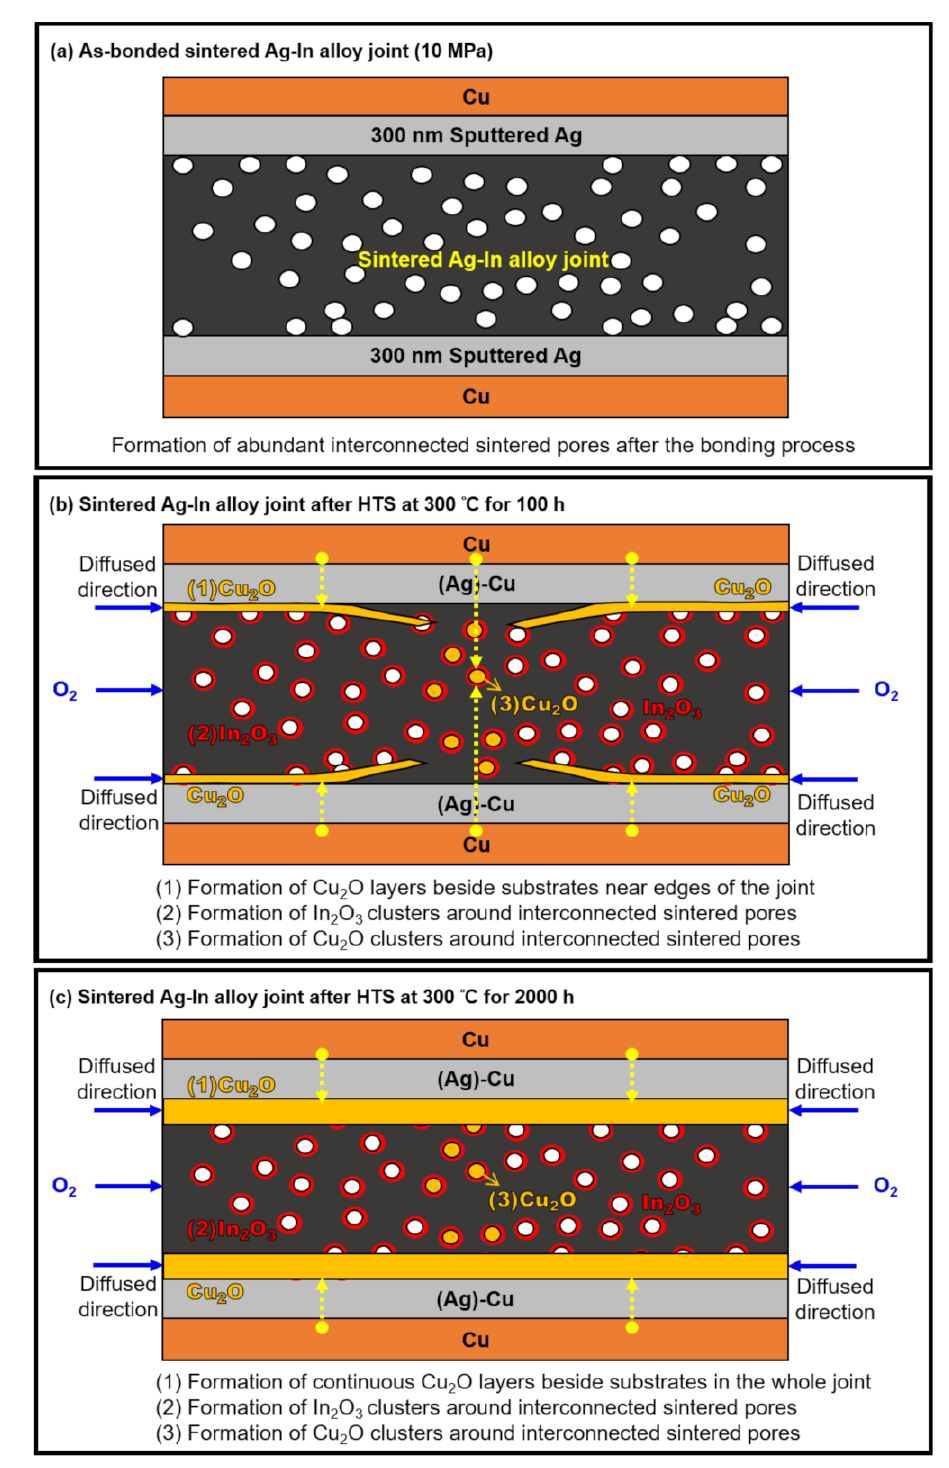
Figure 16. Proposed mechanism for the oxidation process of the sintered Ag–In alloy joints at a bonding pressure of 10 MPa. Schematic drawings for the cross-section of the sintered Ag-In alloy joints after the HTS at 300 ◦ C for ( a ) 0 h, ( b ) 100 h, and ( c ) 2000